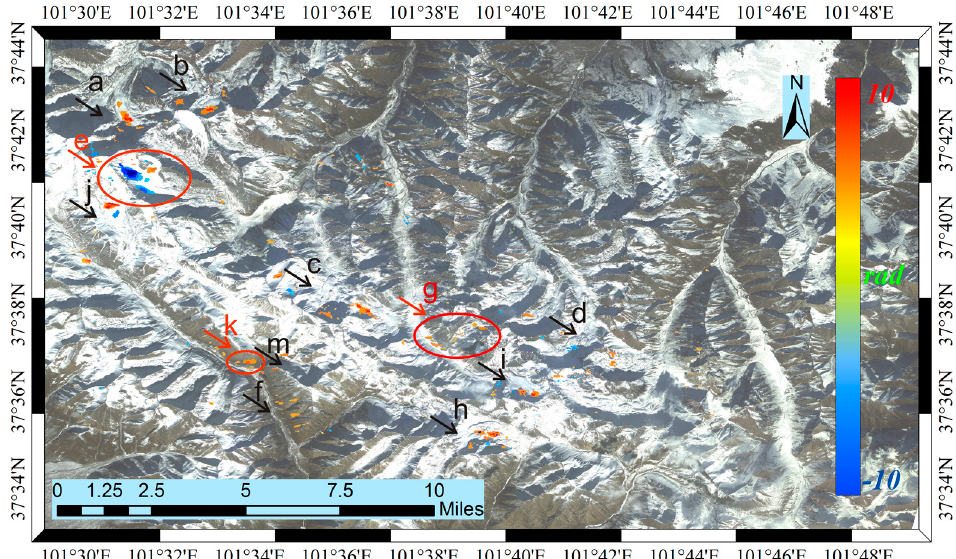
Figure 7. Detected possible geo-hazard areas (highlighted with lowercase letters) superimposed on the Chinese Gaofen-1 optical images; the blue color means moving towards the radar, while the red is moving away from the radar, and the arrows show the line of sight direction.